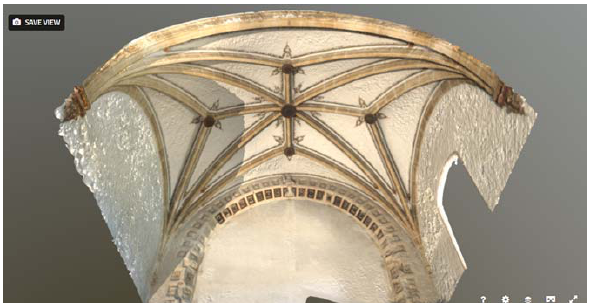
Figure 7: Model 3D with texture shared in Sketchfab